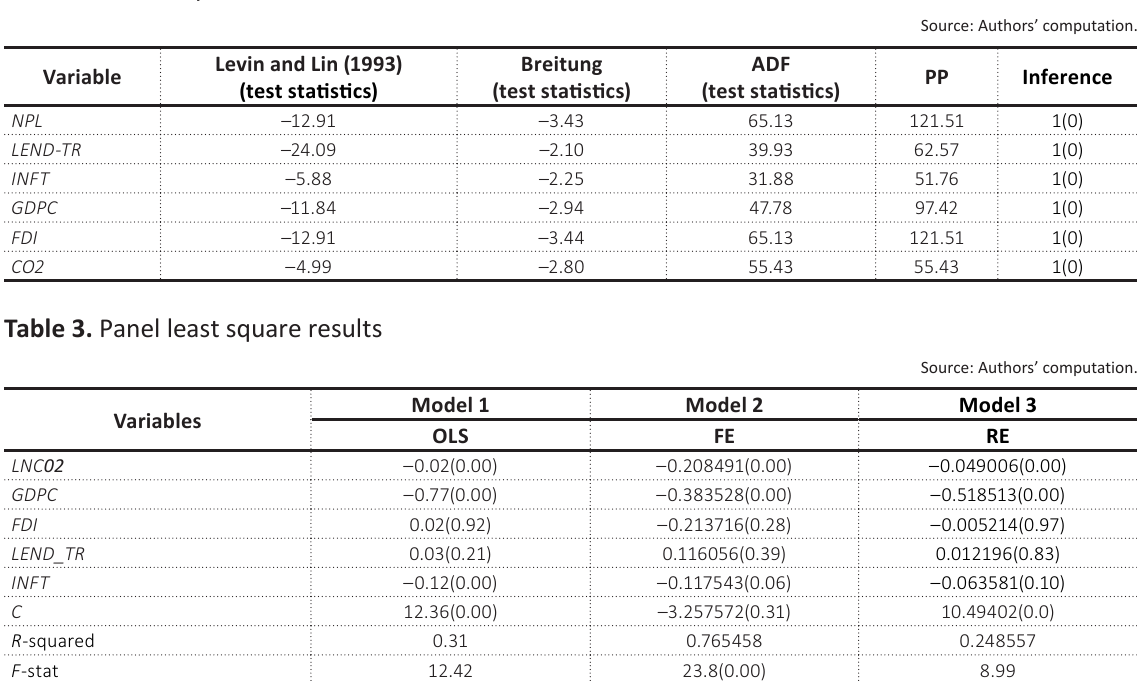
Table 2. Summary of unit root test